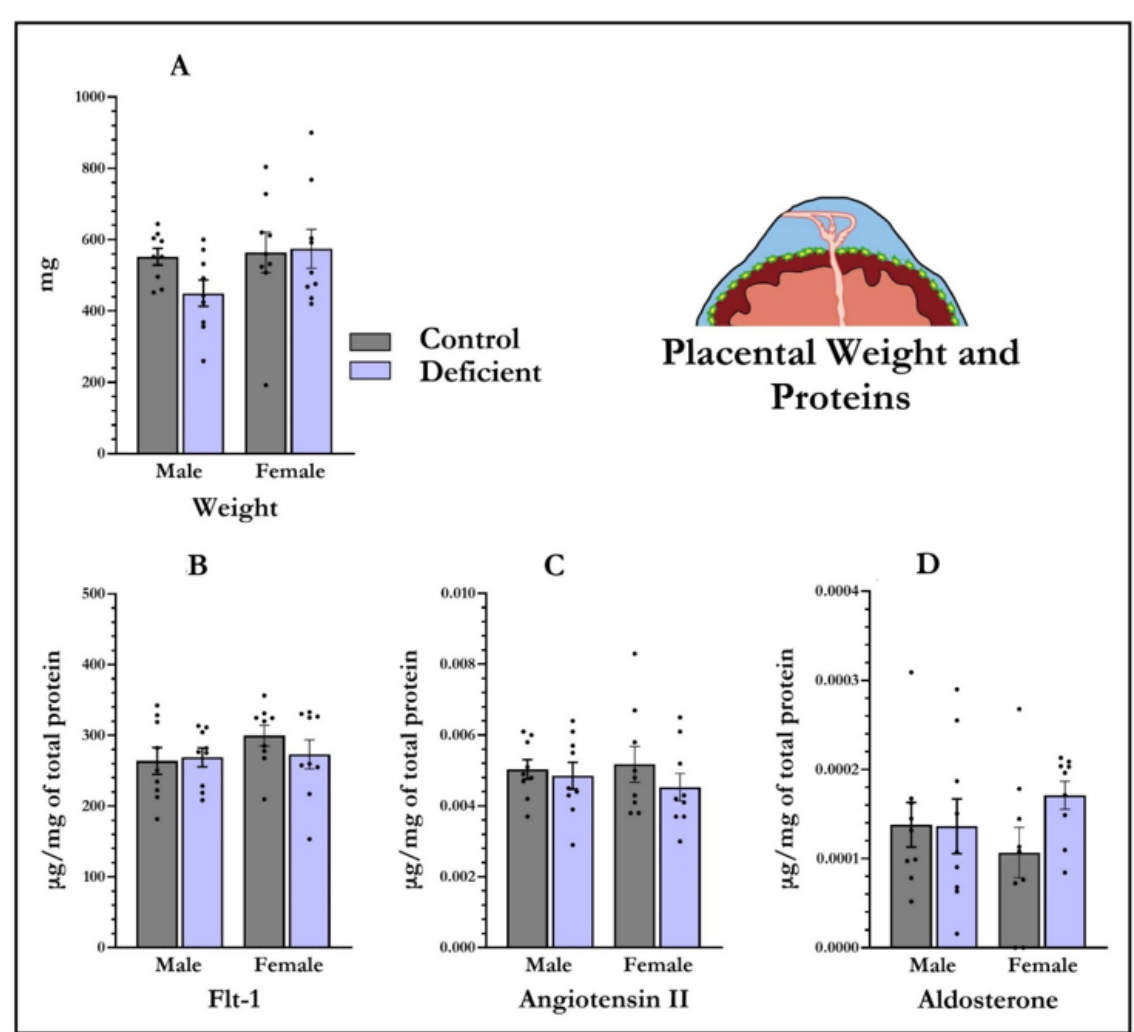
Figure 2. Vitamin-D-deficient pregnant rats do not have alterations in placental weight or expression of proteins central to preeclampsia phenotypes. Placental weight and placental proteins were quantified at gestational day 19. There was no effect of diet on placental weight ( A ). There was also no effect of diet or embryo sex on placental Flt-1 ( B ), angiotensin II ( C ), or aldosterone ( D ). Data shown are means; error bars show SEM; n = 9 control males, n = 9 vitamin-D-deficient males, n = 9 control females, n = 9 vitamin-D-deficient females.